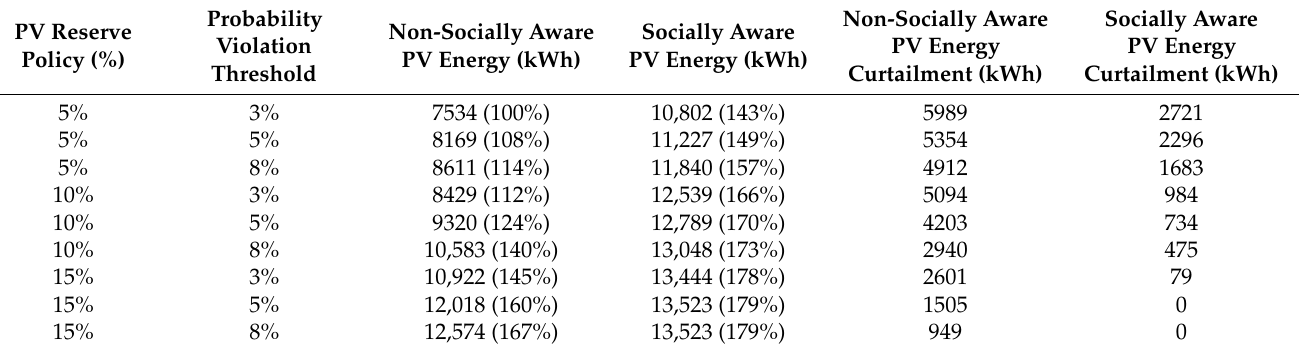
Table 1. Total Scheduled PV Energy for Case I.